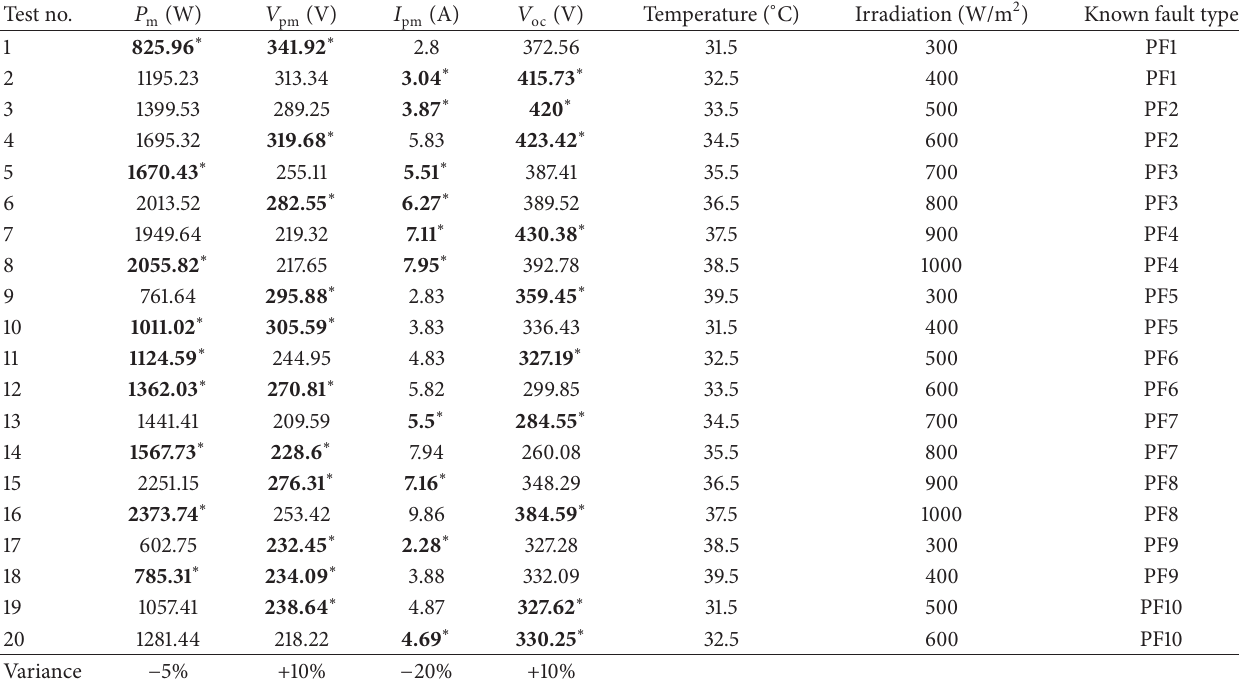
Table 8: Test data with an additional error and under 300–1000 W/m 2 irradiation and PV module surface temperatures between 31 and 40 ∘ C. Test no.